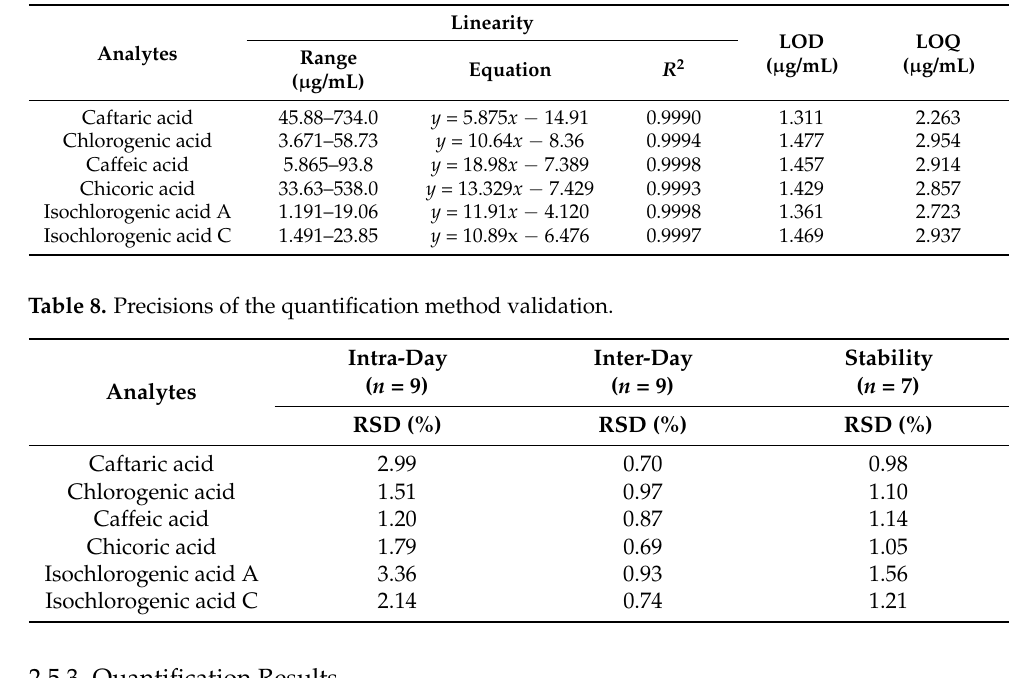
Figure 10. The typical LC chromatograms of blank solvent ( A ), standard solution ( B ), and sample solution ( C ). 1-caftaric acid, 2-chlorogenic acid, 3-caffeic acid, 4-chicoric acid, 5-isochlorogenic acid A, 6-isochlorogenic acid C. Table 7. Linearity, LOQ, and LOD of the quantification method validation.